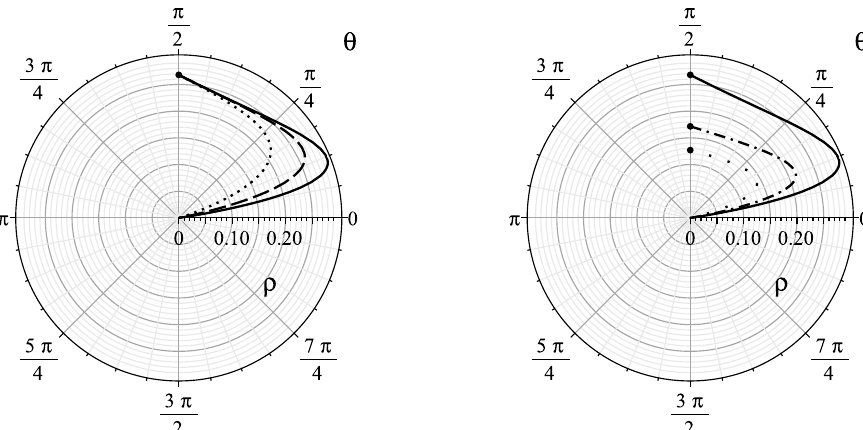
(cid:0) (cid:1) (cid:26) ( t ) ; (cid:18) ( t ) , with (cid:26) being the radial variable on the unit disk, for the